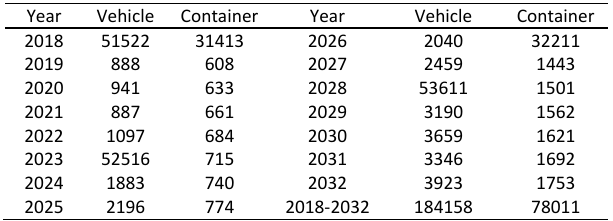
Table 6: Projected the machinery cost for SWCTT in different district of Tehran from 2018 ‐ 2032 (thousand US dollars)